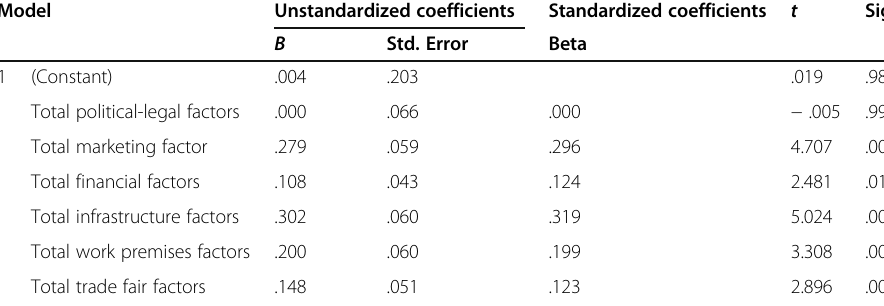
Table 4 Coefficients (dependent variable: total performance factors)